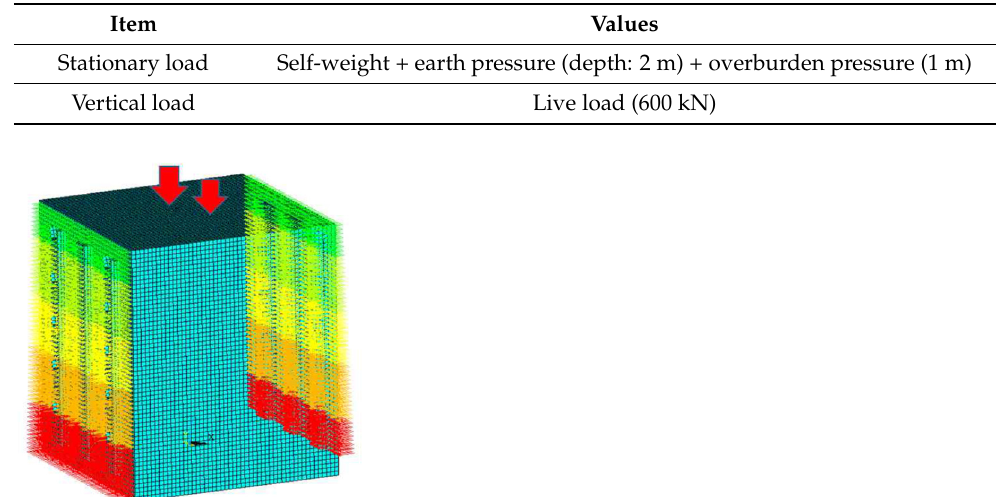
Table 7. Analysis conditions.